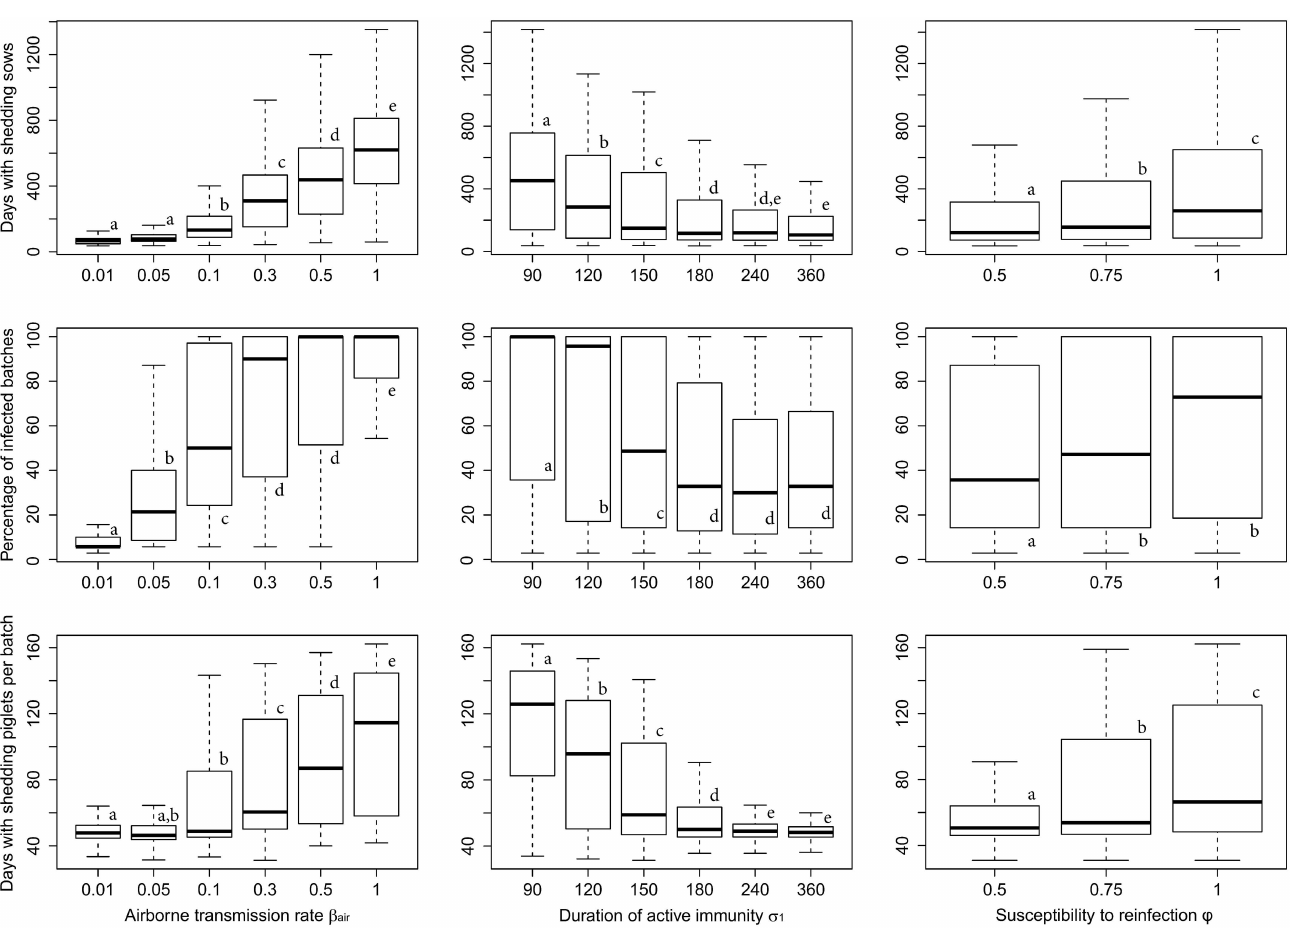
Fig 3. Boxplots representing the exploration of the variation of selected outputs (rows) according to the range of variation of each uncertain factor (columns). The first column corresponds to the variation of the factor “between-batch transmission rate through the airborneroute β air ”, with 6 variation levels. The second corresponds to “the durationof the active immunity period σ 1 ”, with 6 variation levels and the third column correspondsto “the susceptibility to reinfection φ ”, with 3 variation levels. Different letters within panel (a, b, c, d and e) represent statistically different distributions (Kruskal-Wallis